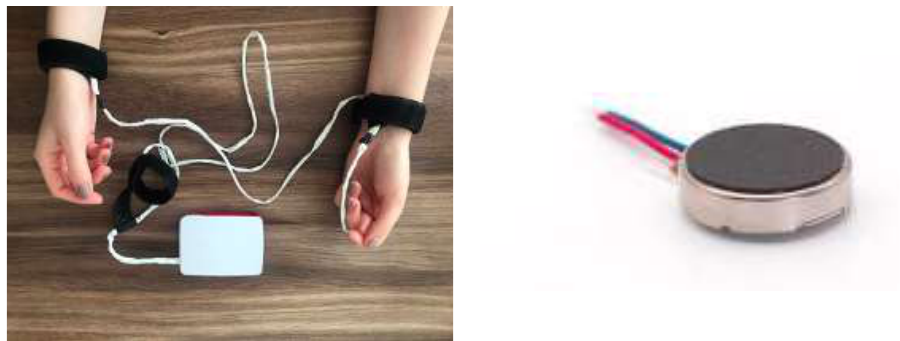
Figure 4. Raspberry Pi 4 with tactile module integrated and the vibration motor 1027 [22].